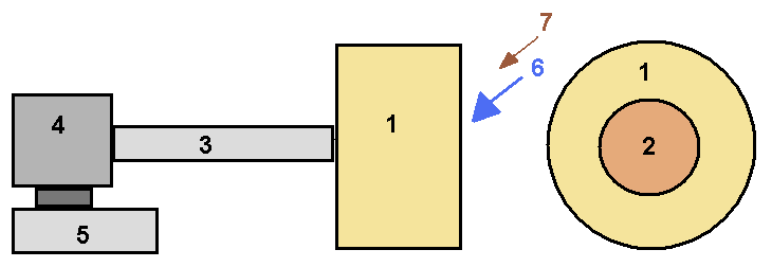
Figure 5. Schematic diagram of the laboratory granulator: 1—drum (diameter 700 mm, width 450 mm); 2—loading opening (diameter 350 mm), 3—shaft; 4—gearbox, 5—electric motor; 6—raw mixture containing liquid glass; 7—dry raw mix.